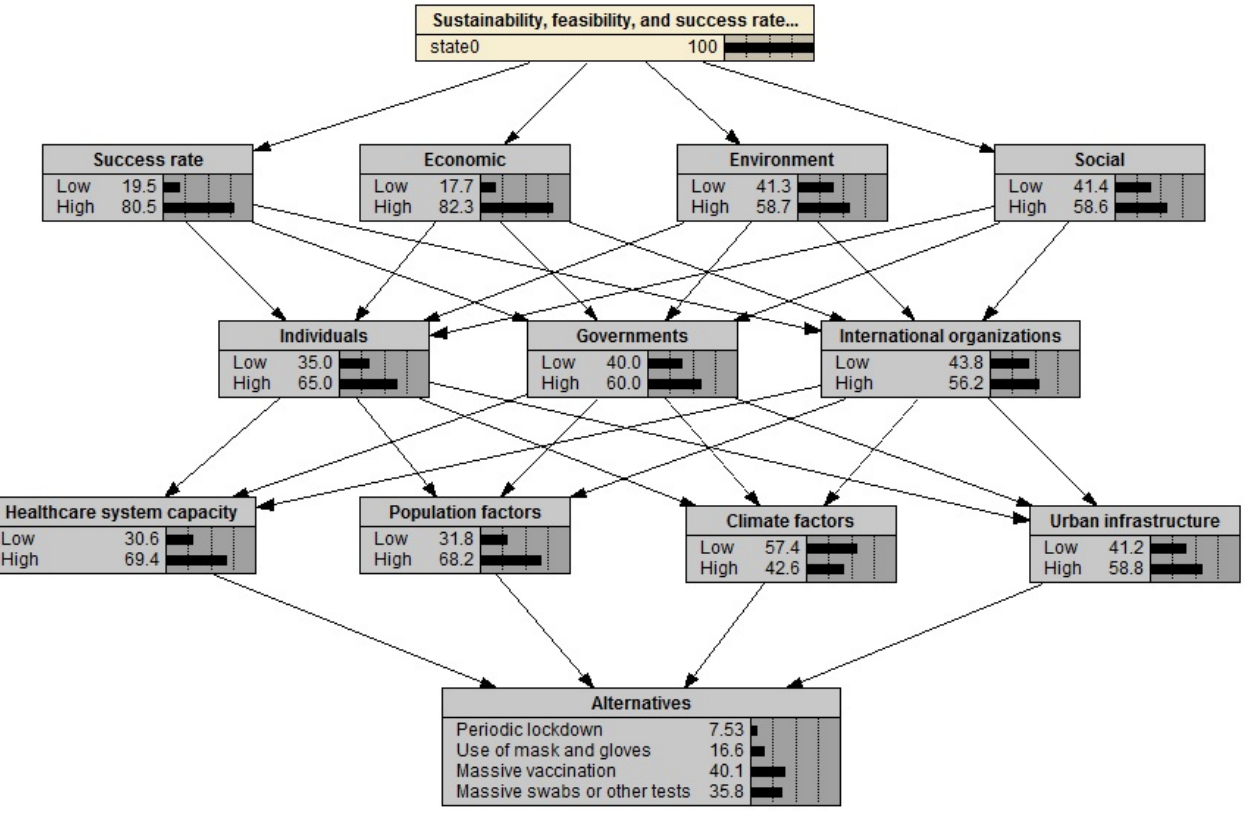
Figure 4. The developed BN-Geo-AHP.